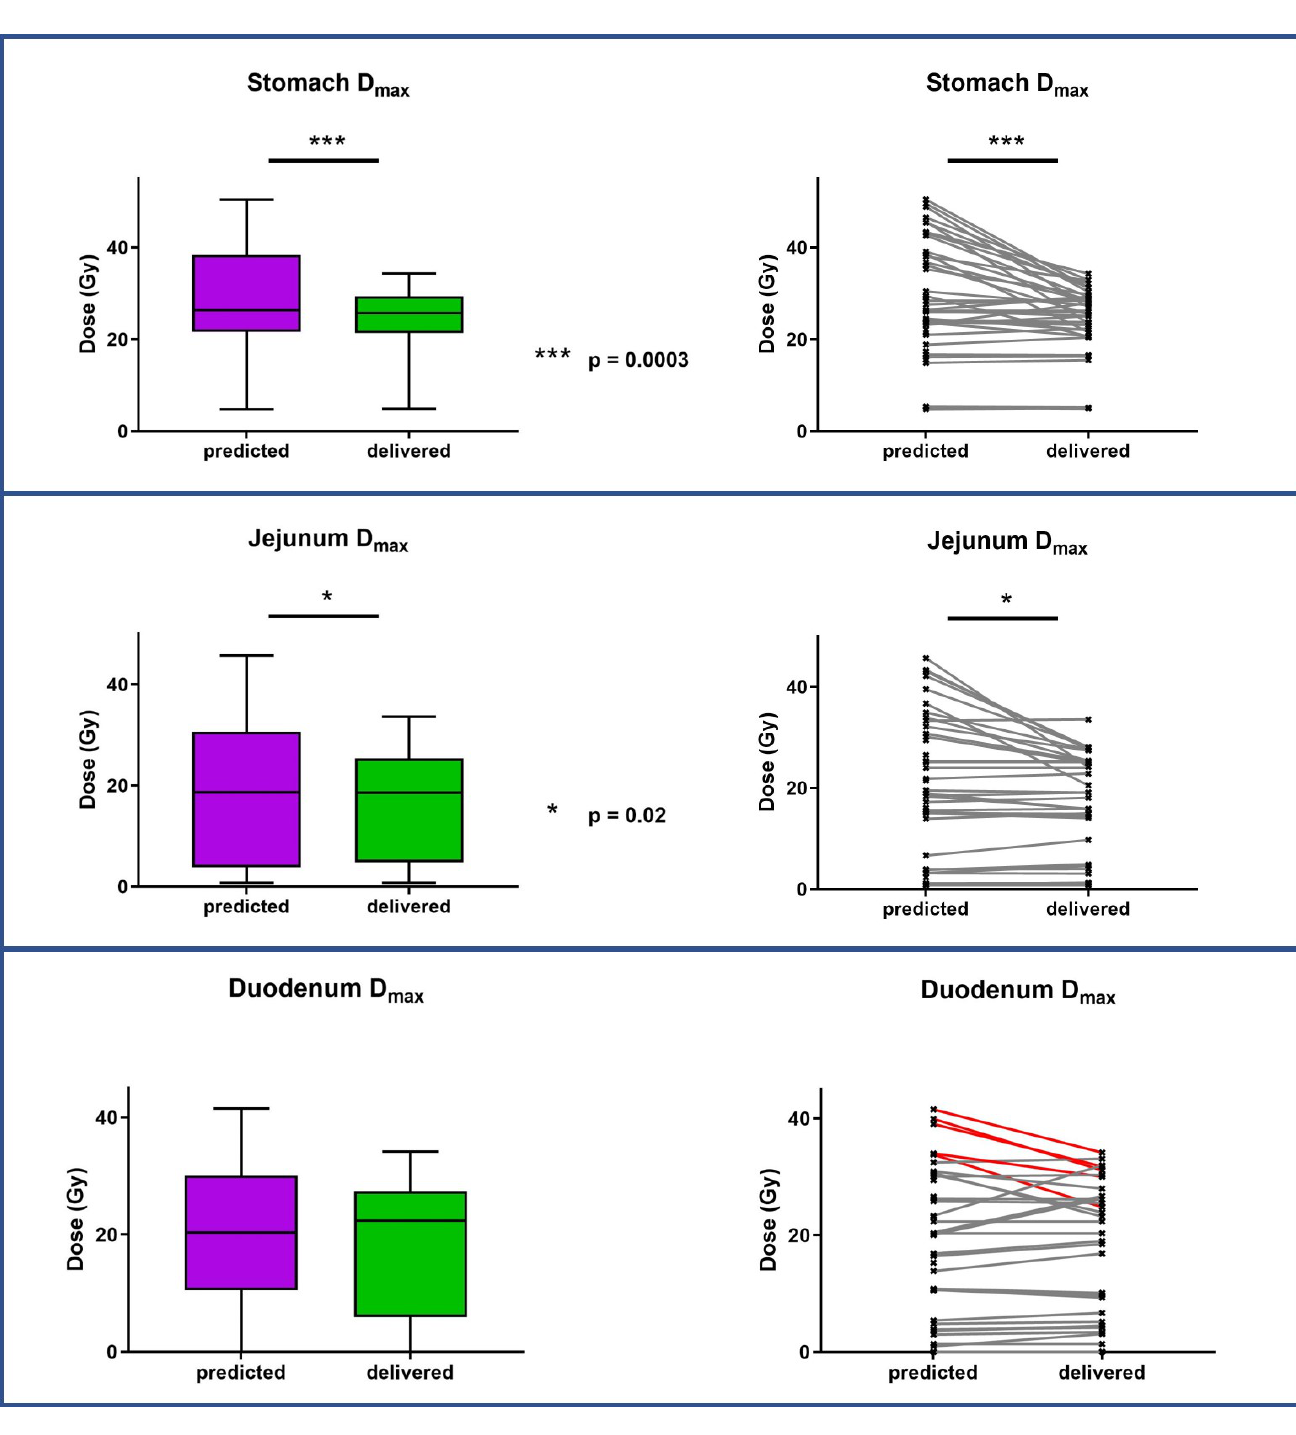
Figure 3. Organs at risk dose variations between predicted fractions (baseline plan on daily anatomy) and delivered fractions (new plan on daily anatomy). Table 4. Average target volume dosimetric results for the predicted and adapted/delivered plans.